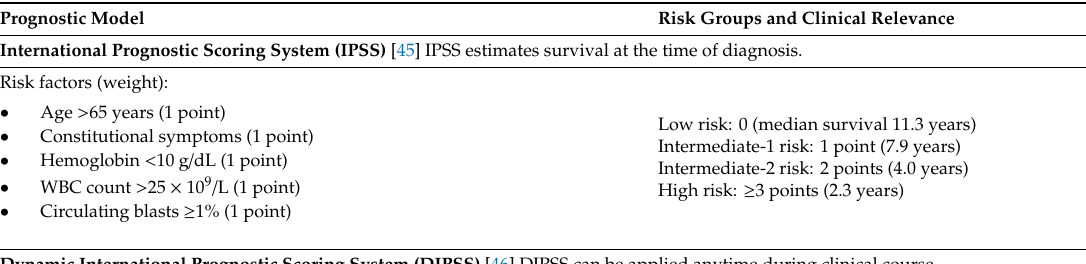
Table 2. Prognostic models in primary